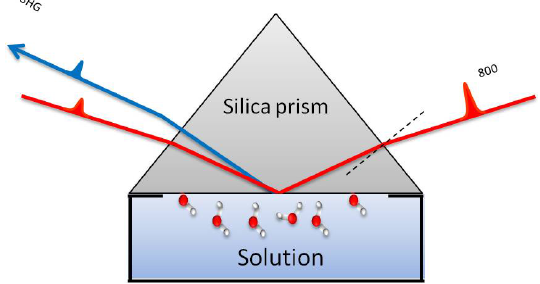
Figure 1. Sample and beams geometry (see text for